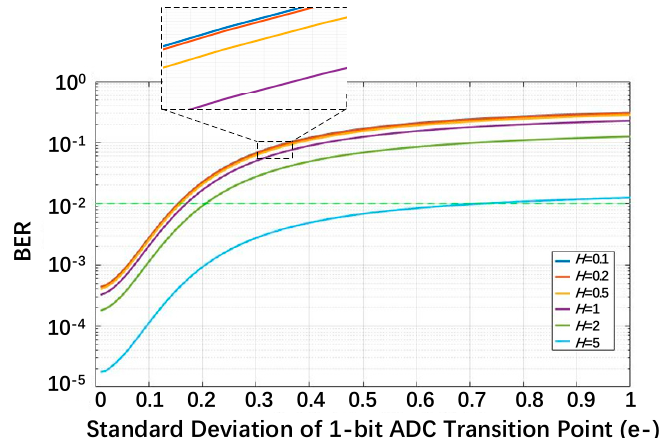
Figure 3. The bit error rate (BER) for a single-bit QIS as a function of the standard deviation of the transition point for different exposure levels with the read noise fixed at U n = 0.15e − . ADC, analog-to-digital converter.